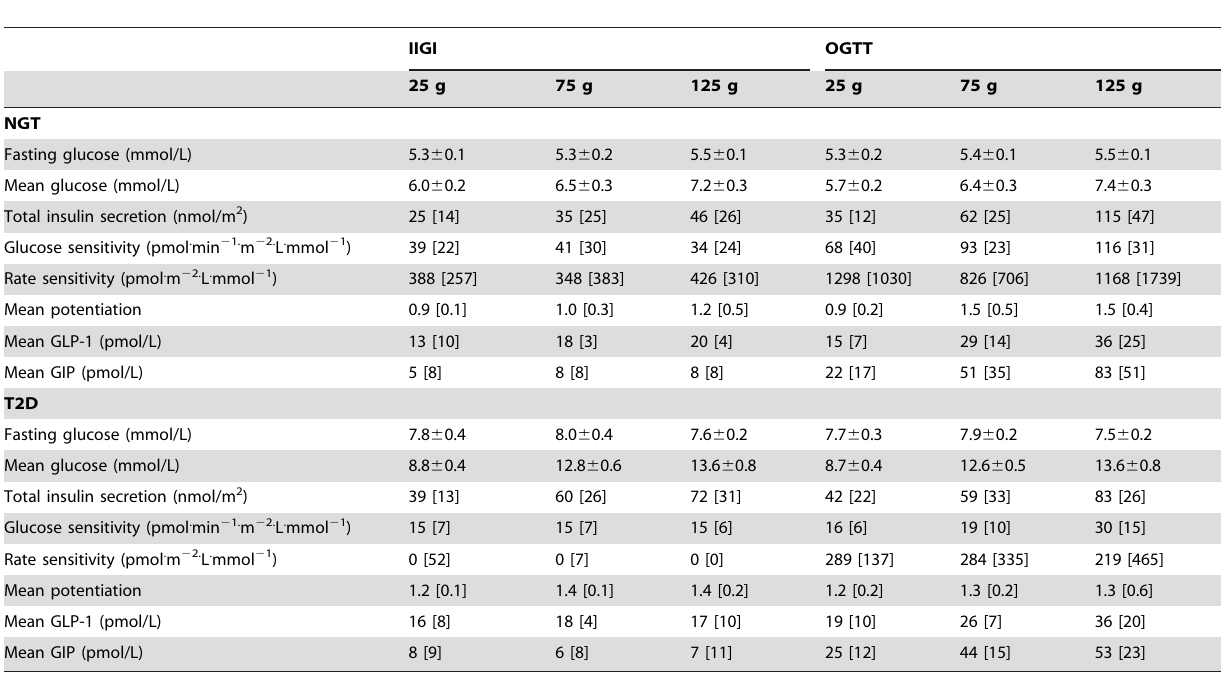
Table 1. Metabolic and b -cell function parameters (mean 6 SE or median [interquartile